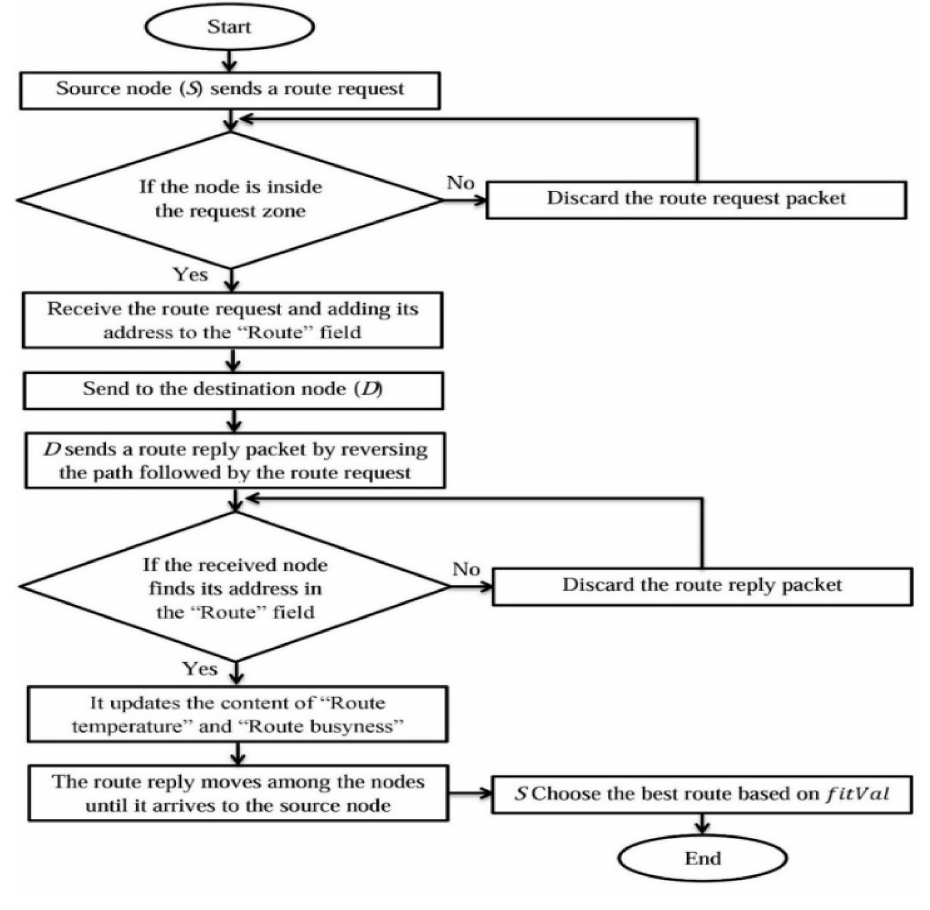
Figure 8. Flowchart of LARRR protocol.